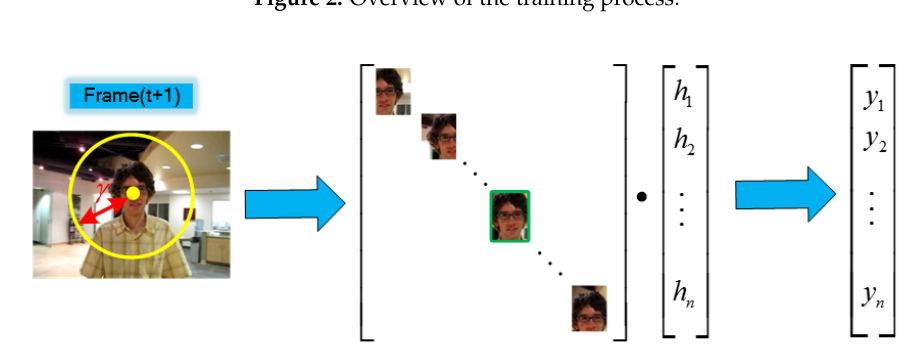
Figure 2. Overview of the training process.